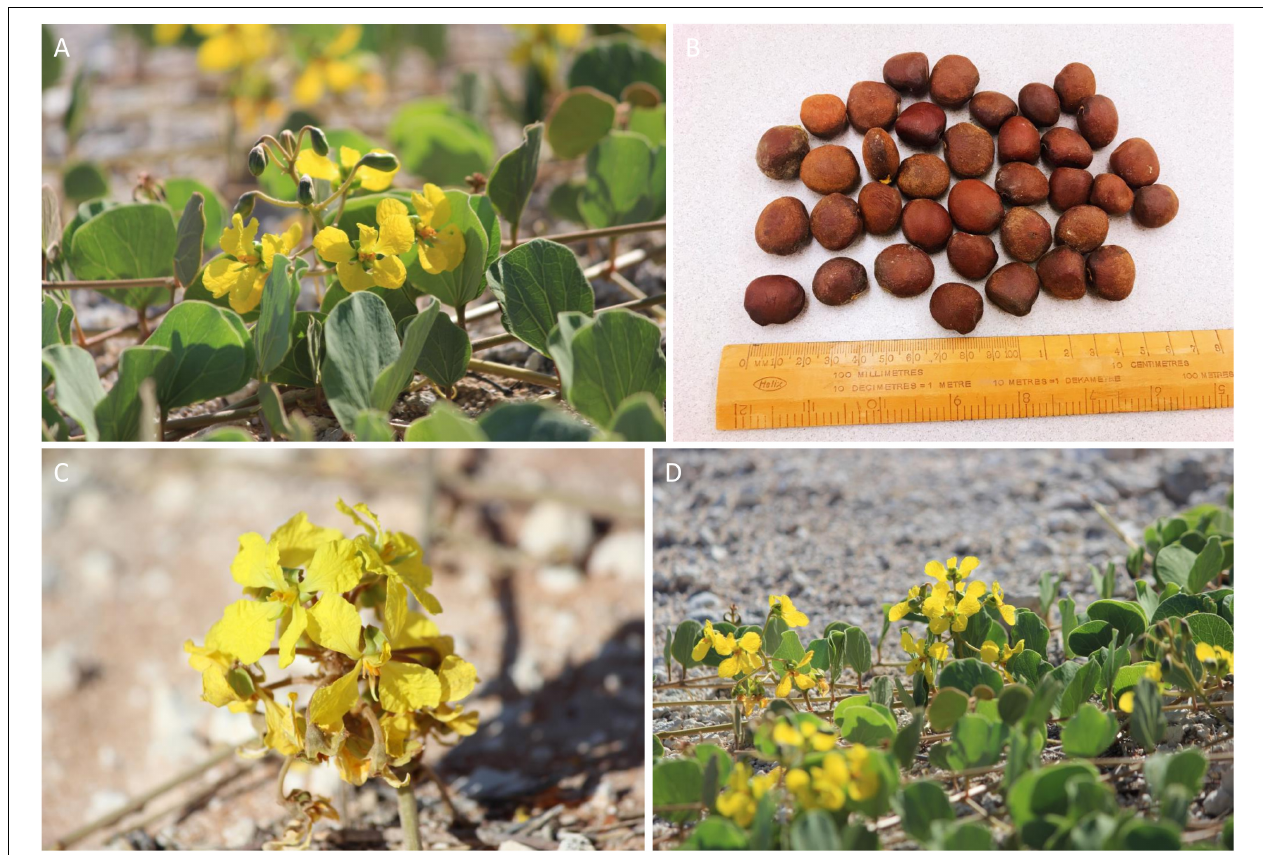
FIGURE 1 | Morphology of marama ( Tylosema esculentum ) plants from Namibia. (A) Double-lobed leaves, soft and red-brown when young, become leathery and gray-green over time (National Research Council [NRC], 2006). (B) Brownish-black seeds, edible after roasting and rich in protein, lipids, and micronutrients (Jackson et al., 2010). (C) Yellow-orange flowers, bloom every midsummer from the 3rd or 4th year after planting (Bower et al., 1988). (D) Prostrate vines, can grow up to six meters or longer for mature plants (Vietmeyer,